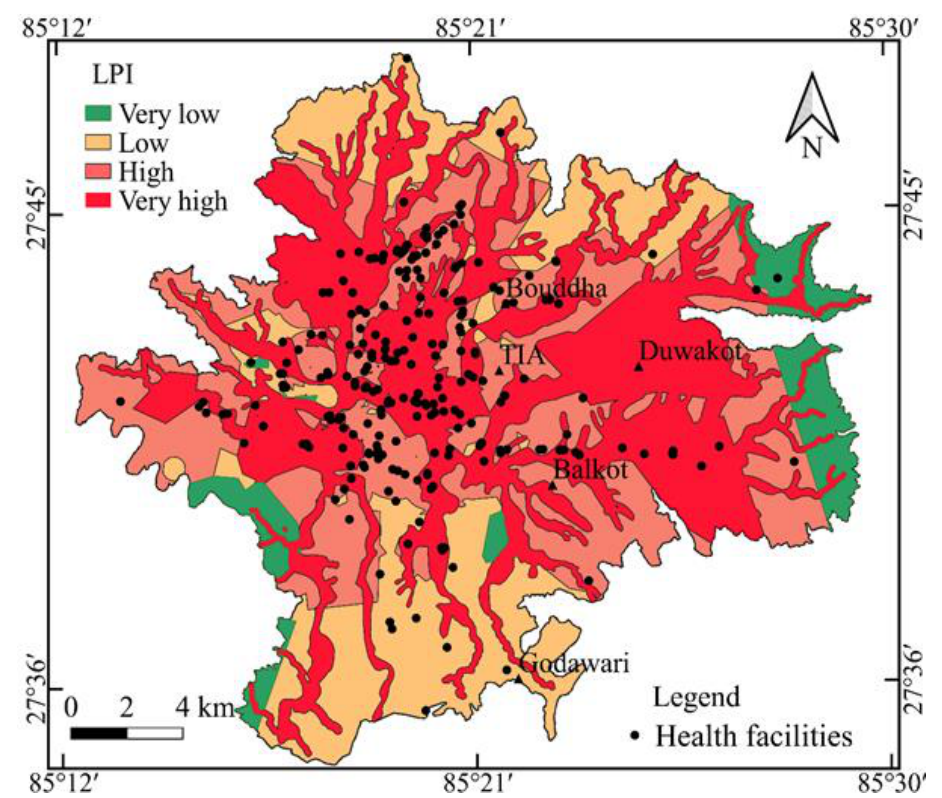
Figure 13. Liquefaction susceptibility map with health facilities of Kathmandu Valley.